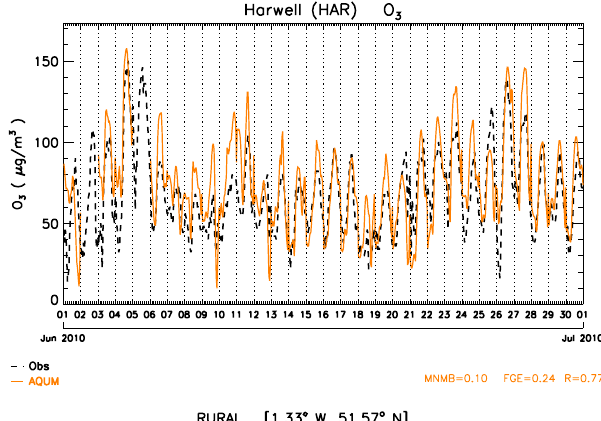
Fig. 8. Time series of hourly ozone concentrations (µgm − 3 ) for the rural site Harwell for June 2010. Observed concentrations are shown as the black dashed line and the model output as the solid orange line.